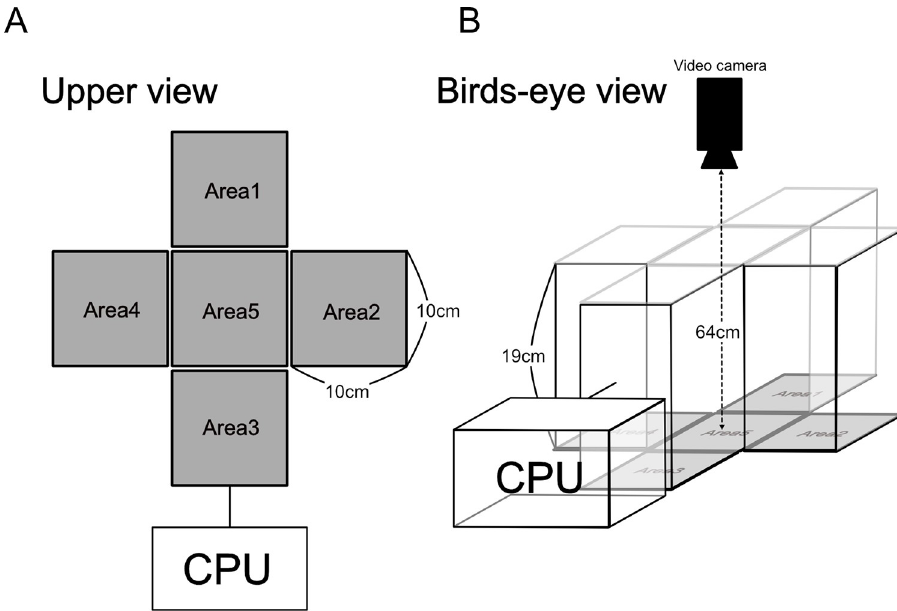
Fig 1. Experimental system used for the assessment of heat-escape/cold-seeking behavior. (A) Upper view. Five Peltier boards (10 × 10 cm) were placed at the bottom of the system in a cross-shape (Areas 1–5). The temperature of each board could be independently controlled using a computer. (B) Bird’s-eye view of the system. The five areas were surrounded by Plexiglas walls with a height of 19 cm. The walls were painted black to minimize the influence of light entering